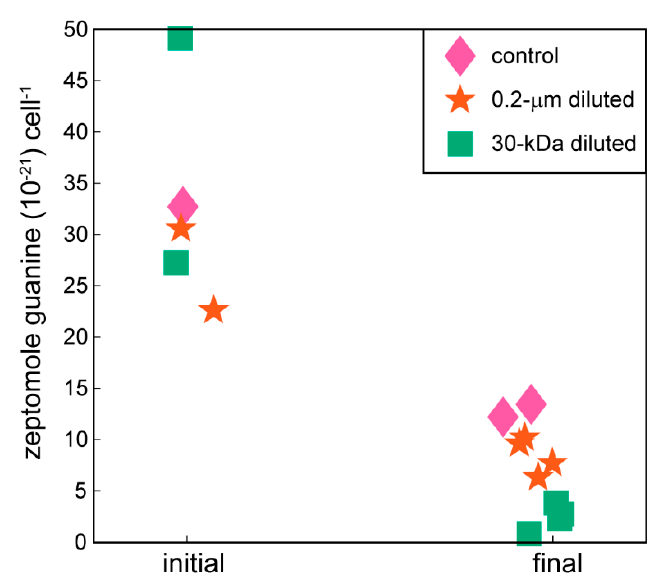
Figure 2. Cell-specific guanine concentrations at the initial and final time points of the experiment. Guanine is one example of a nucleic acid precursor measured with the targeted metabolomics method used in this project. Data are biological replicates from different bottles. The remaining nucleic acid precursors are plotted in Supplemental Figure S2.